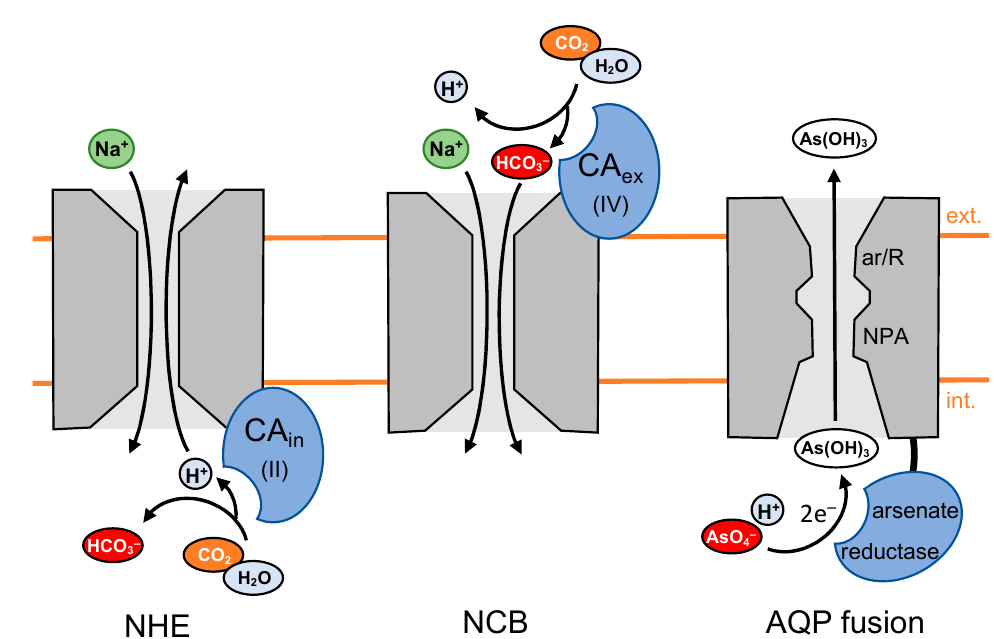
Figure 4. Enhancement of transmembrane transport by enzyme activity, providing weak acid/base substrates or co-substrate close to the transporter entry sites. Shown are co-localizations of CA isoforms with the sodium–proton exchanger, NHE (left), and the sodium-bicarbonate symporter, NCB (center), as well as a fusion protein between an aquaporin and an arsenate reductase (right).